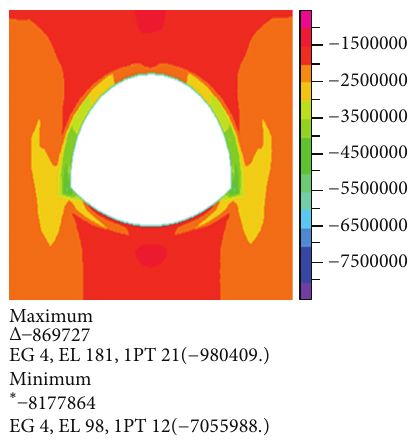
Figure 8: Nephogram of the third principal